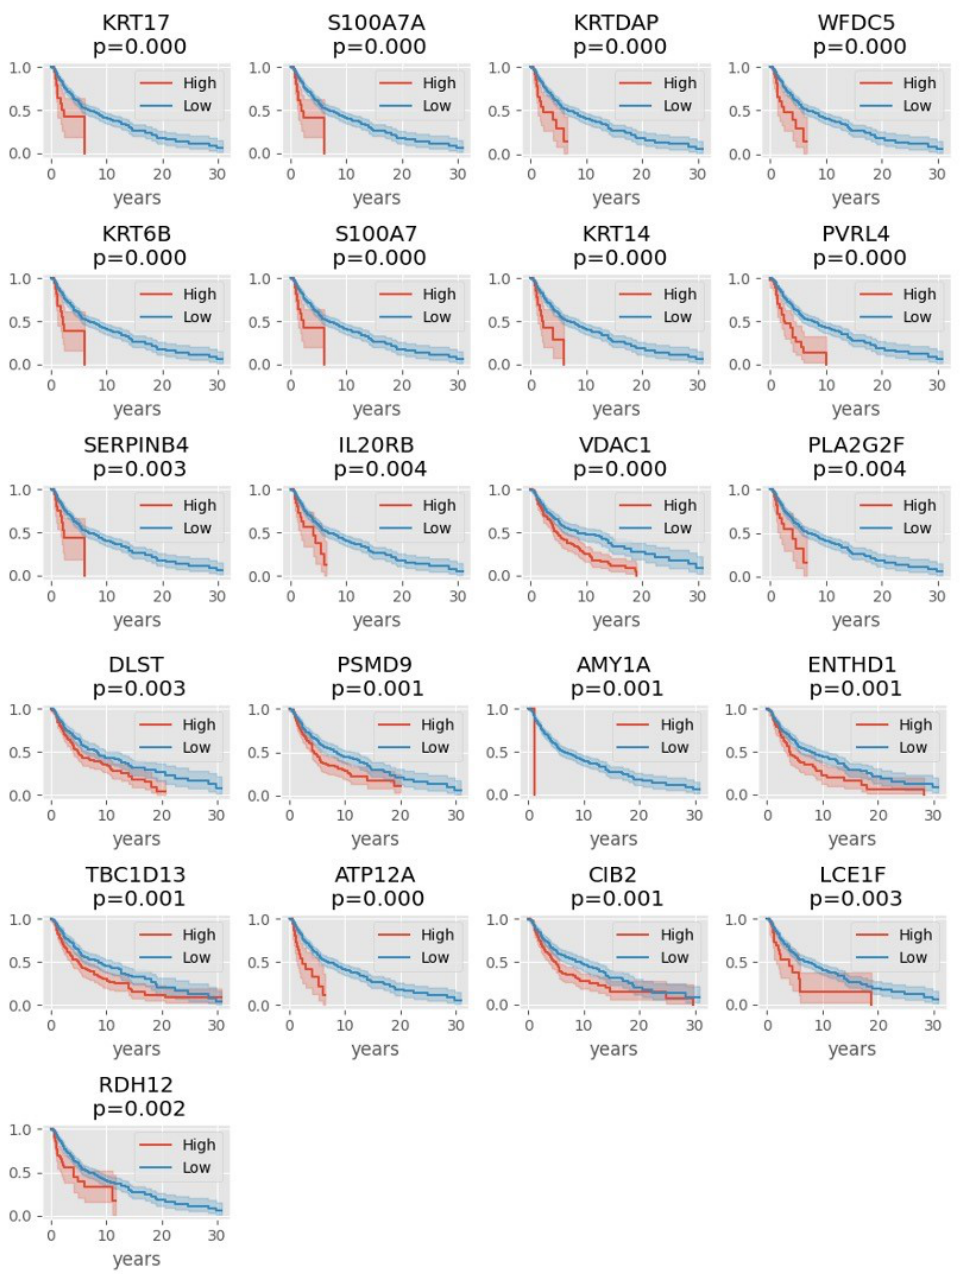
Figure 3. Kaplan-Meier plots showing that the red lines (high expressor) fall faster than the blue lines (low expressor) for each gene. The y -axis represents the probability of survival, thus, high expressors (red line) of these 21 genes have worse survival. In this analysis, the patient samples were divided in terms of the average of gene expression (high = above the mean, low = below the mean). On the other hand, high expression of LYSMD2, PSTPIP2, SNAP23, TSHR, or CCPG1 is associated with better survival (Figure 4). Herein, 11 of these 26 prognostic genes, KRT17 , S100A7A , KRTDAP , WFDC5 , KRT6B , S100A7 , KRT14 , PVRL4 , SERPINB4 , IL20RB and TSHR , are common with the 26 genes identified by the ensemble classifier (Table 6).